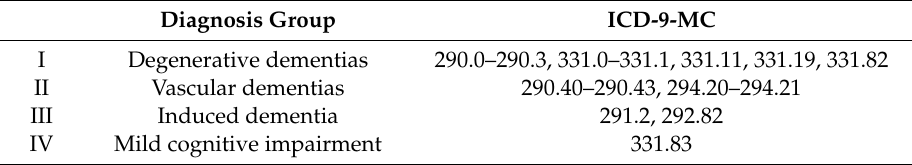
Table 1. Main diagnoses for hospital discharges and associated ICD-9-MC